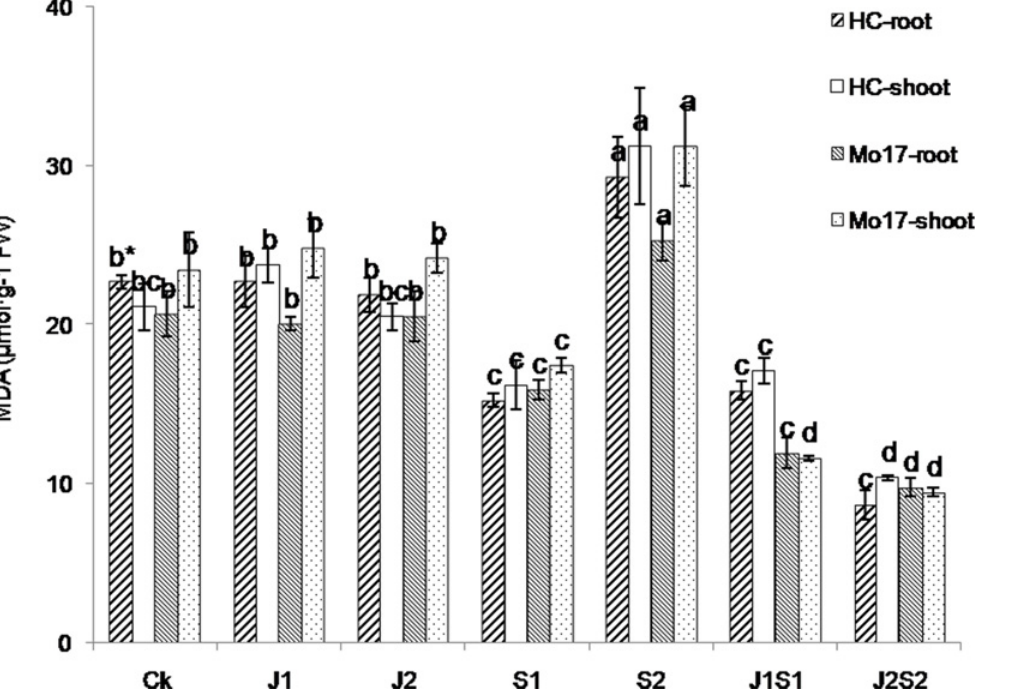
Fig 9. Effect of coating agent on seedling malondialdehyde (MDA) content of maize varieties Huang C (HC) and Mo17 after chilling stress. ( * significant difference (a = 0.05, LSD) among treatments within the same seedling part for the same variety. Error bars represent ± S.E. For additional explanations, see Fig.